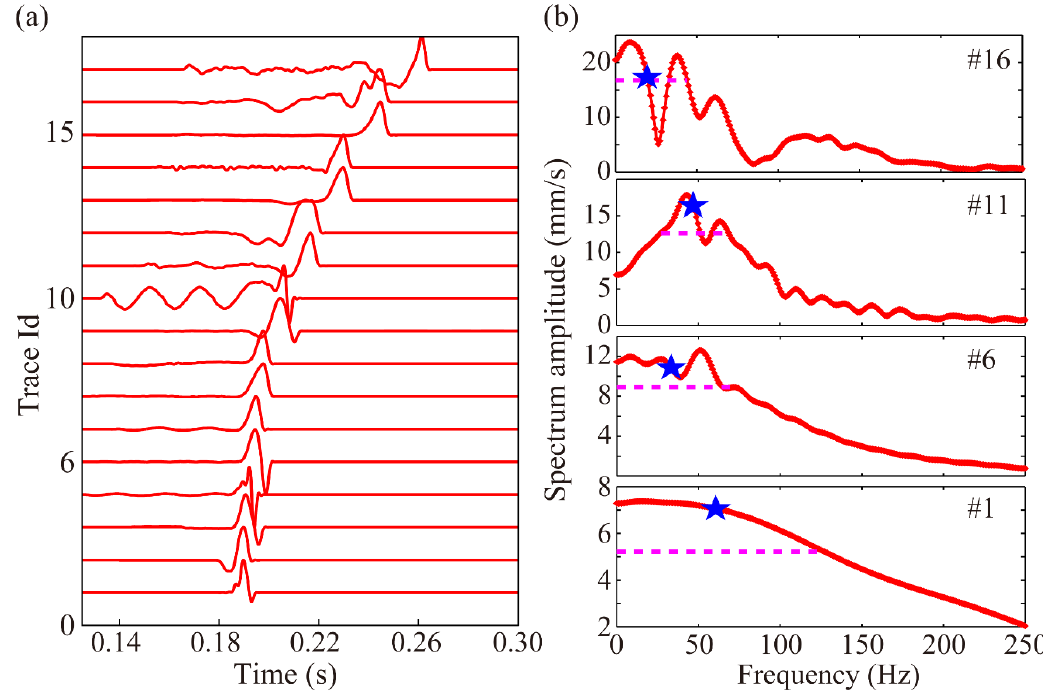
Figure 4. Windowed waveforms of the realistic blasting event 1 ( a ) and representative amplitude spectra of some windowed waveforms ( b ). The blue star represents the main frequency of the waveform and the pink dashed line corresponds to the approximate dominant frequency band.